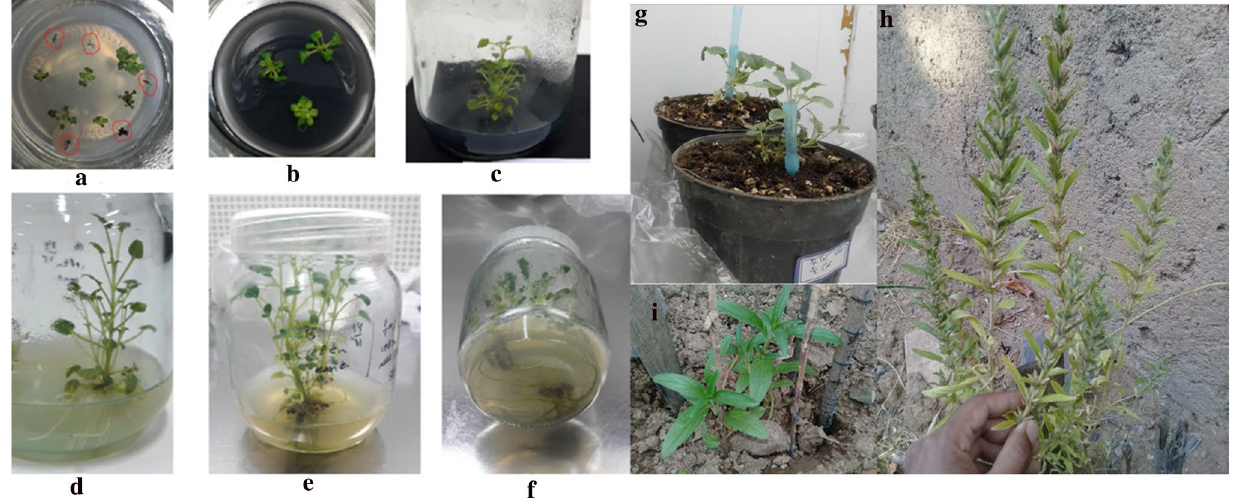
Figure 6. Regeneration of explants in selective medium containing 60 mg l −1 Kanamycin plus 400 mg l −1 cefotaxime after inoculation of explants with Agrobacterium cells. ( a ) Regeneration of putative transgenic plantlets (green plantlets) and non-transformed plantlets (Red circles) after two weeks of culture; ( b ) Sub- culturing of putative transgenic plantlets; ( c ) further development of plantlets in a new medium; ( d , e , f ) root initiation of regenerated shoot in MS medium containing 0.1 mg l −1 NAA and 60 mg l −1 kanamycin; ( g )